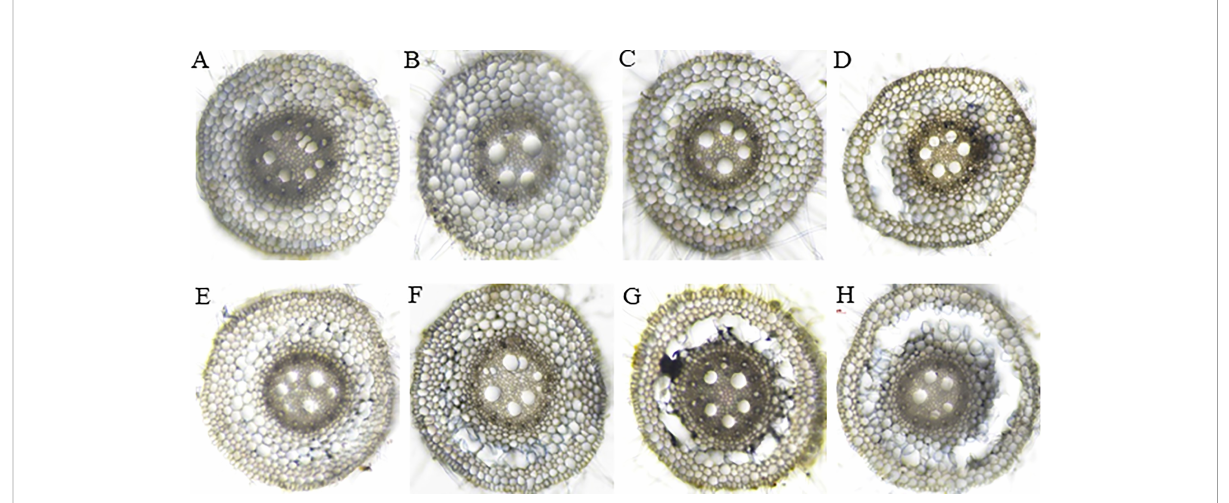
FIGURE 6 Aerenchyma formation in the root cross-section sampled at 4 cm from the root tips in wheat genotypes with different degrees of aerenchyma formation after waterlogging treatment. Upper panel: H-195; Bottom panel: H-242. (A, E) , (B, F) , (C, G) , and (D, H) : waterlogging for 1, 3, 5 and 7 days, respectively.